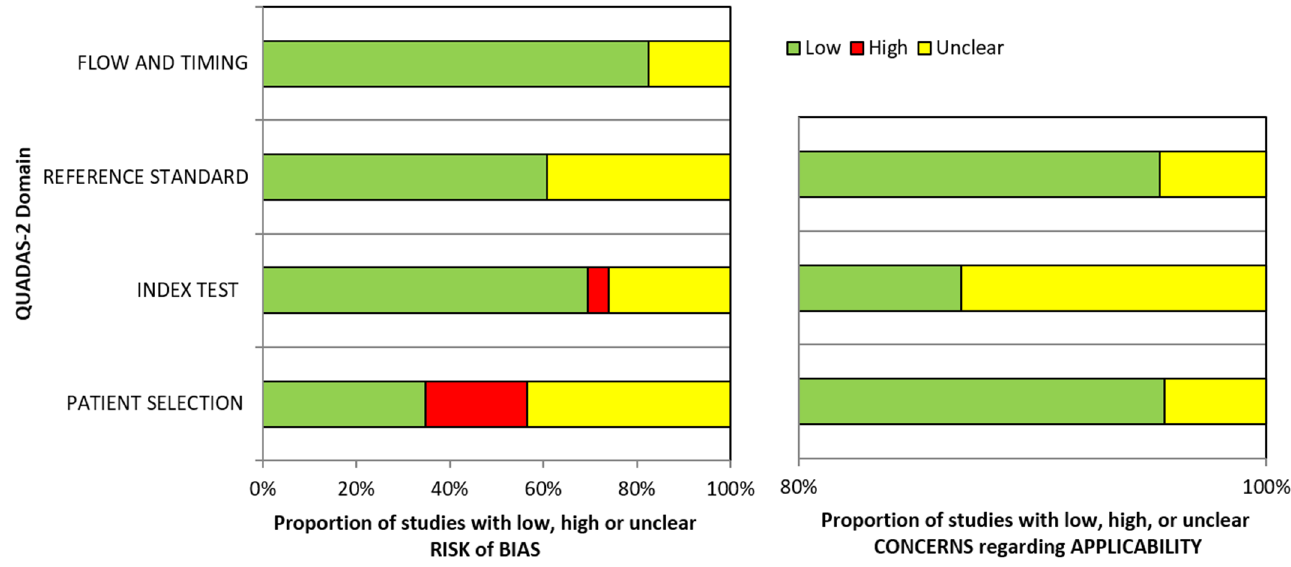
Figure 2. Weighted barchart for the risk of bias and application concerns of the selected studies according to the QUADAS-2 guidelines.